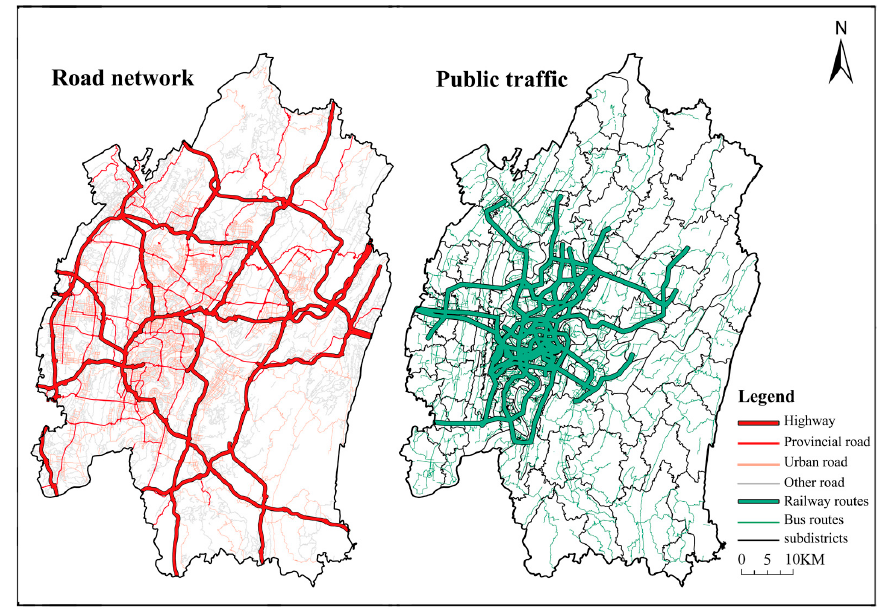
Figure 3. The location and Transport network of the main urban area of Chongqing.